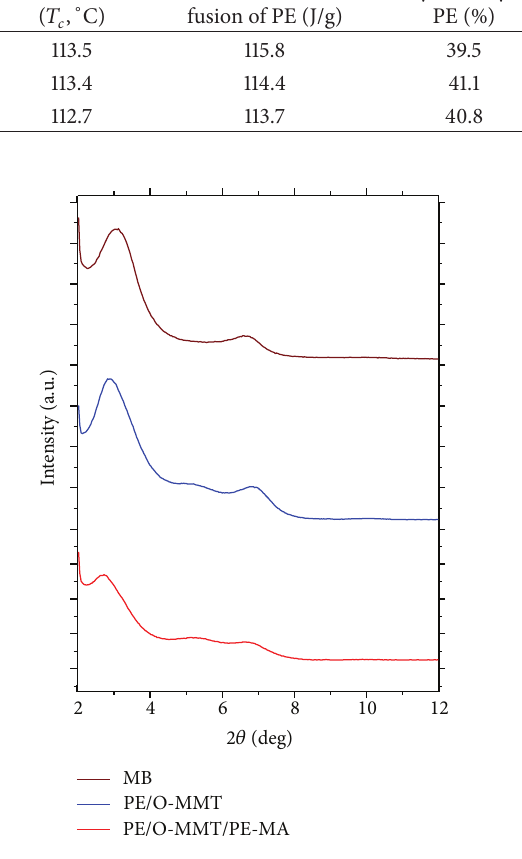
Figure 3: X-ray diffraction patterns for MB and PE nanocomposites with and without